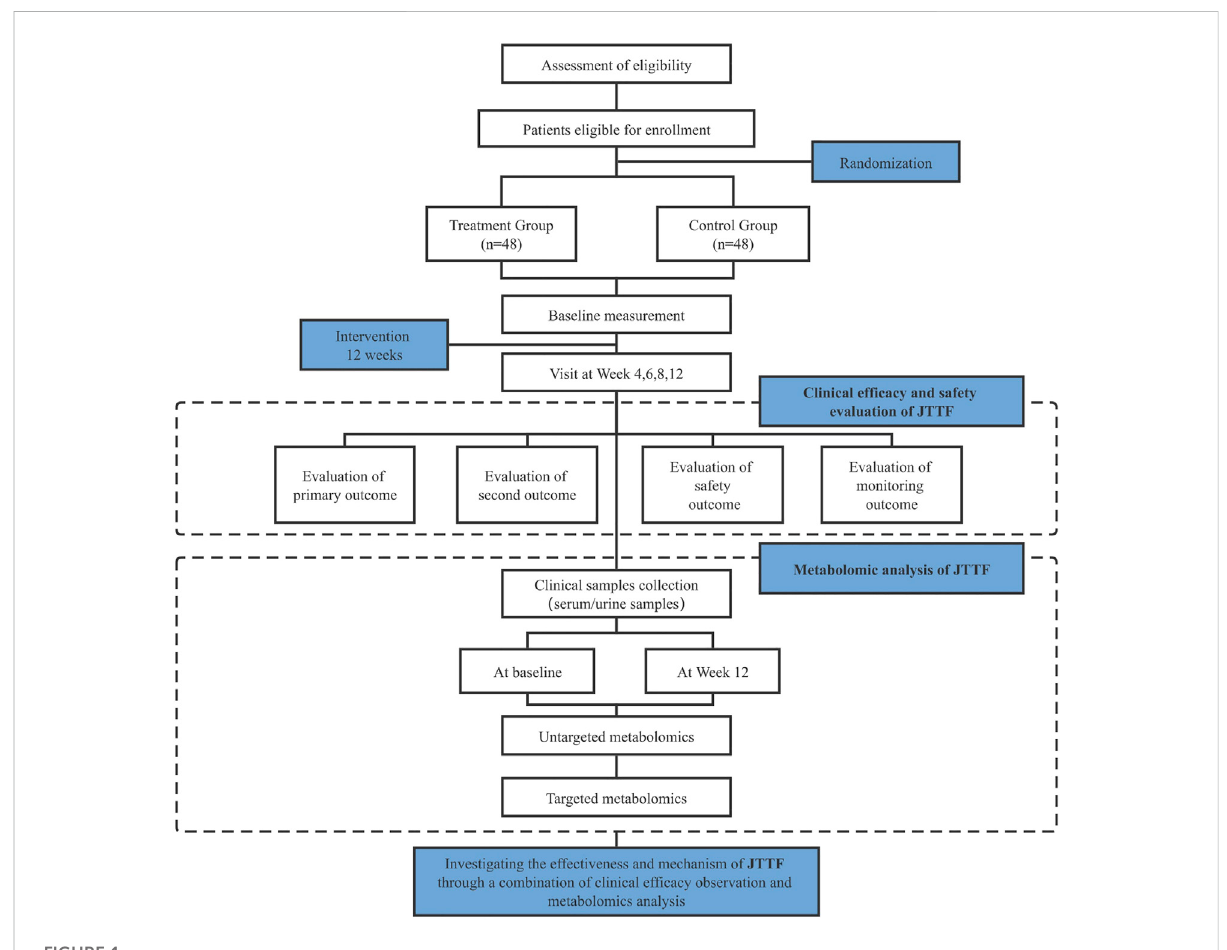
FIGURE 1 Flow chart of the clinical